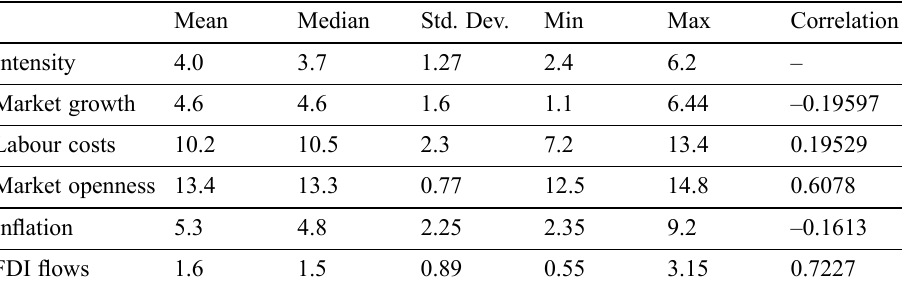
Table 3. Summary of Descriptive